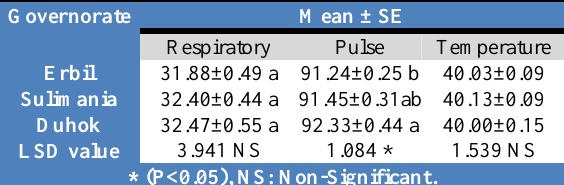
Table, 2: Shows the Statistical Analysis of clinical examination goats in the three